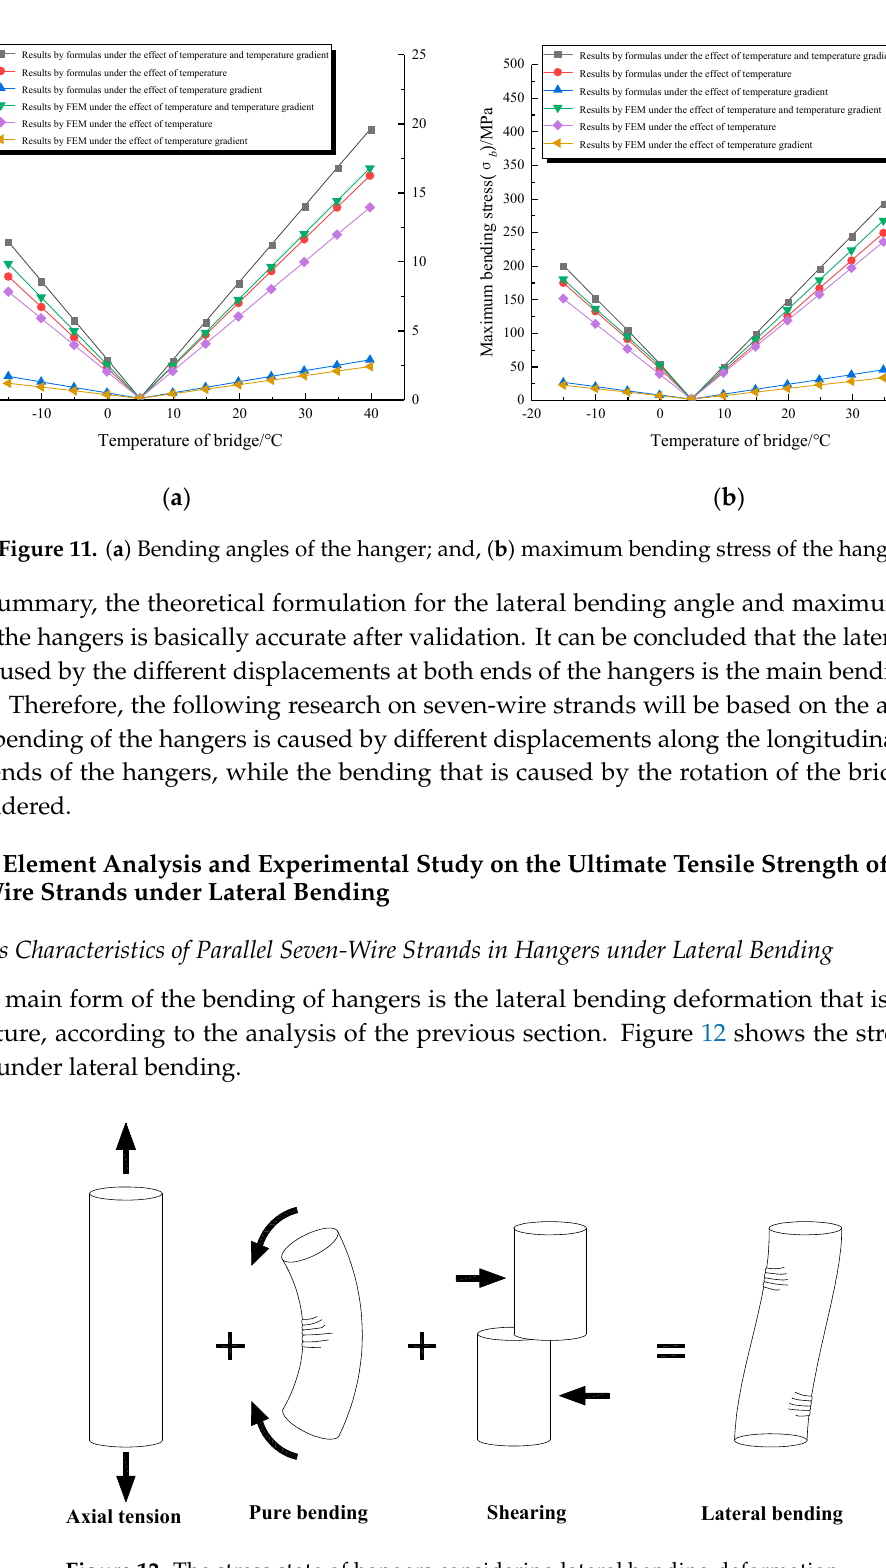
Figure 12. The stress state of hangers considering lateral bending deformation.